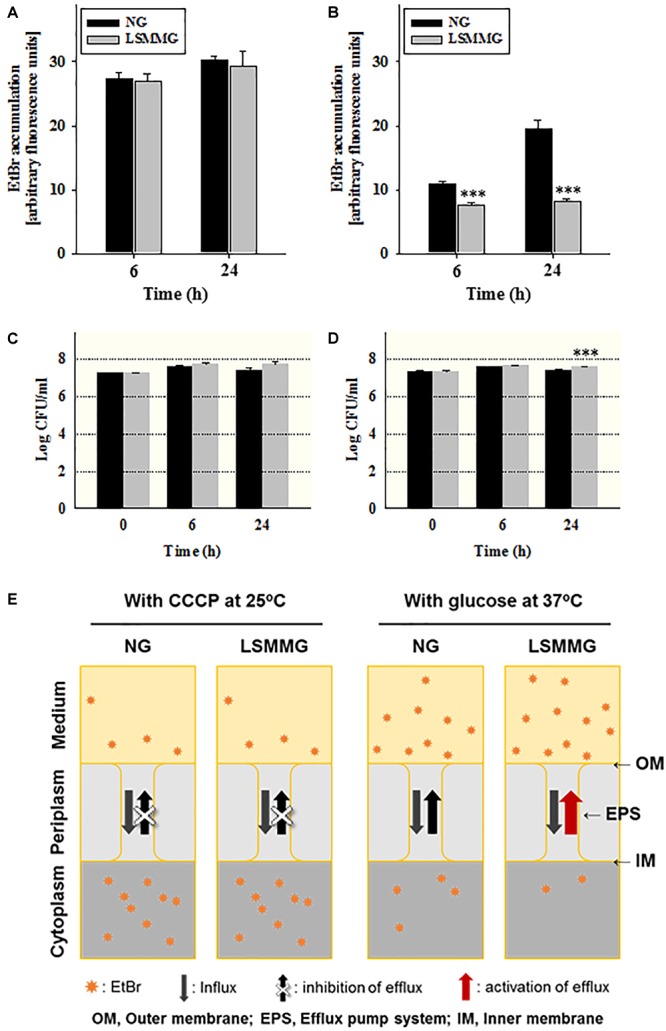
EtBr accumulation in E. coli O157:H7 ATCC 43895 cells cultured under NG and LSMMG for 24 h in (A) the presence of 100 μM CCCP at 25°C and (B) the presence of 0.4% glucose at 37°C. (C,D) Viable cell counts after each treatment from (A,B), respectively. The data are presented as the mean ± standard error (SE) from six independent experiments. The asterisks represent significant differences between NG and LSMMG cultures (∗P < 0.05, ∗∗P < 0.01, and ∗∗∗P < 0.001). (E) A schematic representation of EtBr efflux under NG and LSMMG.